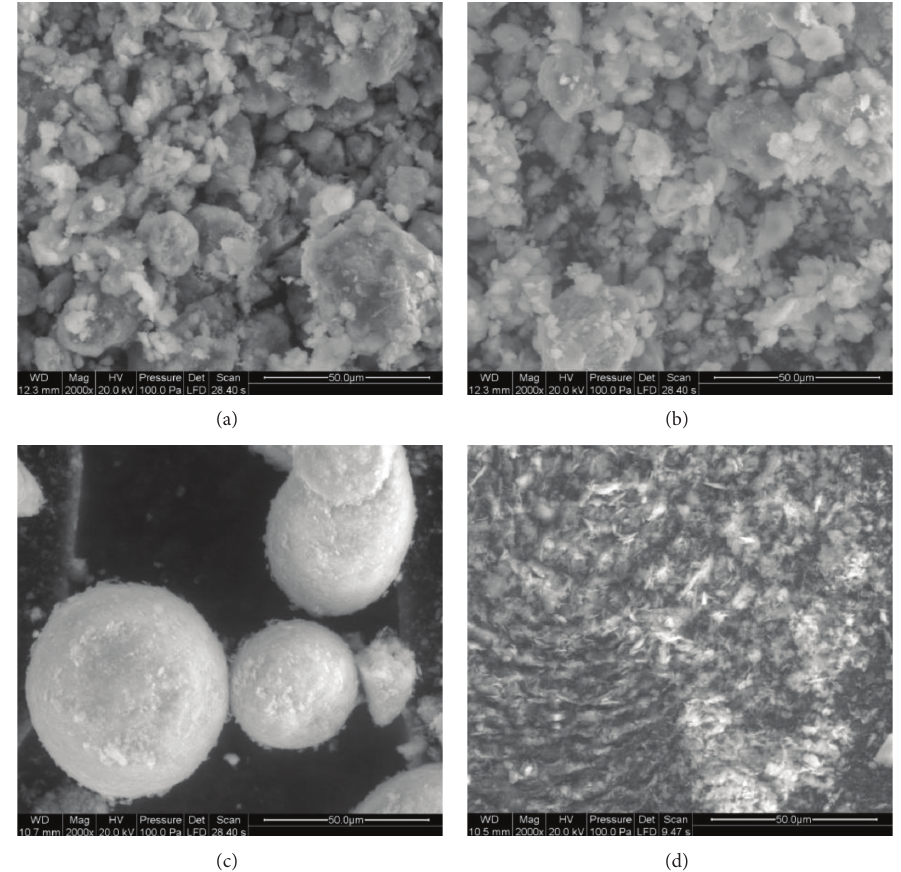
Figure 4: SEM images of MT (a), CMT (b), KL (c), and CKL (d).